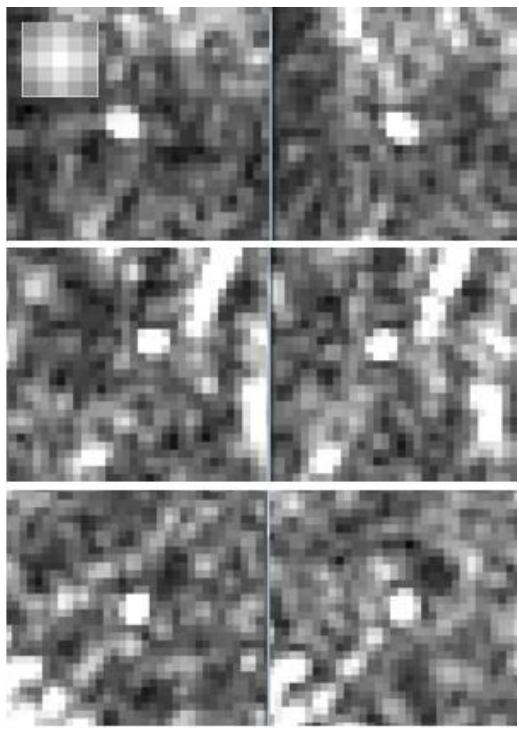
Figure 3. template and some point like target on images